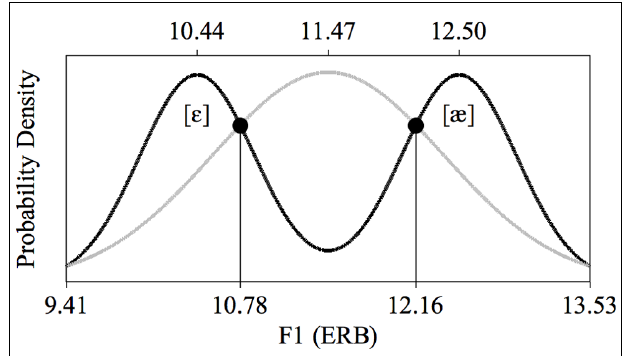
FIGURE 1 | Unimodal (gray curve) and bimodal (black curve) training distributions of the first vowel formant (F1). The values of the test stimuli lie at the intersections of the two